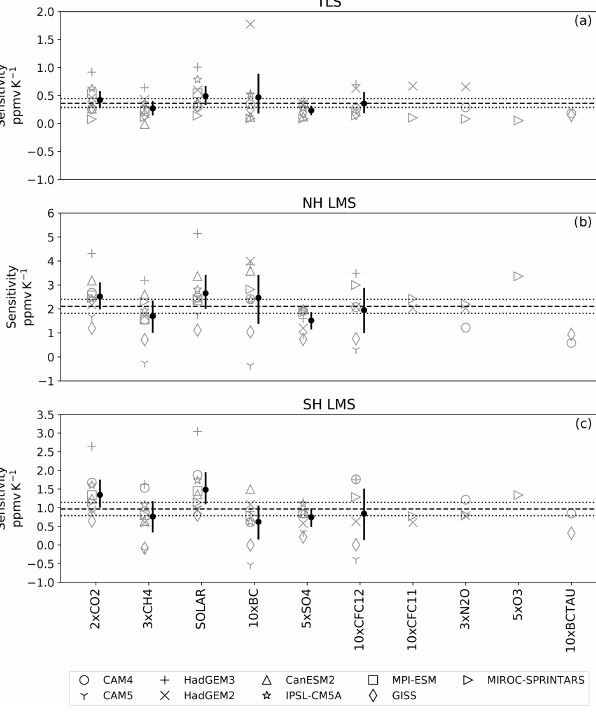
Figure 3. Slopes (ppmvK − 1 ) from the linear regression between annual mean (cid:49) SWV slow time series and annual mean (cid:49)T s time se- ries. The marker shapes indicate results from different models. For perturbations that are performed by more than three models, the solid circles and error bars for each perturbation plotted in solid black are the multi-model mean and 2.5–97.5 percentiles of the model samples. The horizontal dashed line is the multi-model mean of all slopes, and the horizontal dotted lines are 2.5–97.5 percentiles of the model